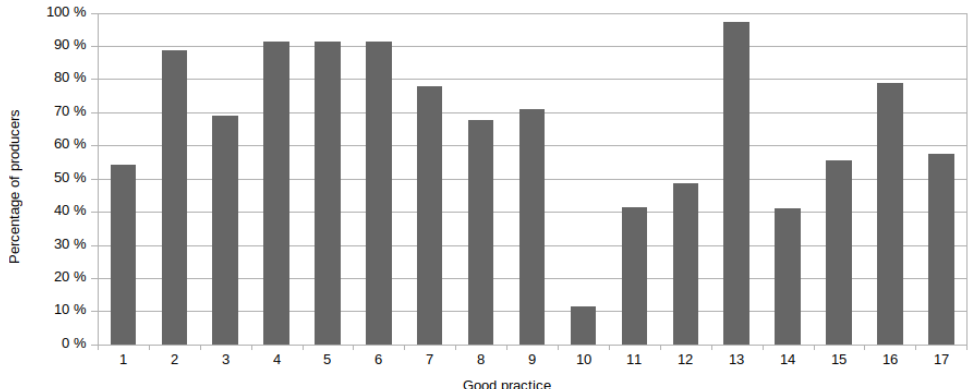
Figure C4. Percentage of vegetable producers adopting each GP.